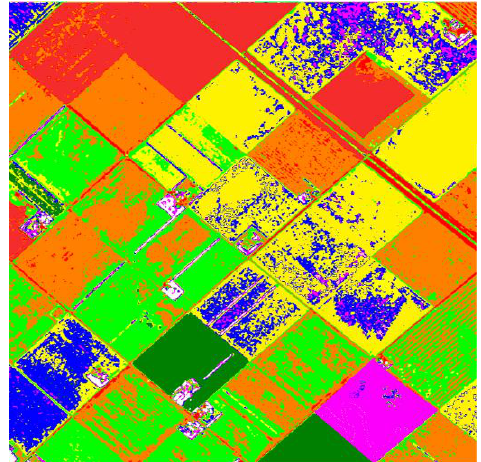
Figure 9. Final classification map produced with proposed method.